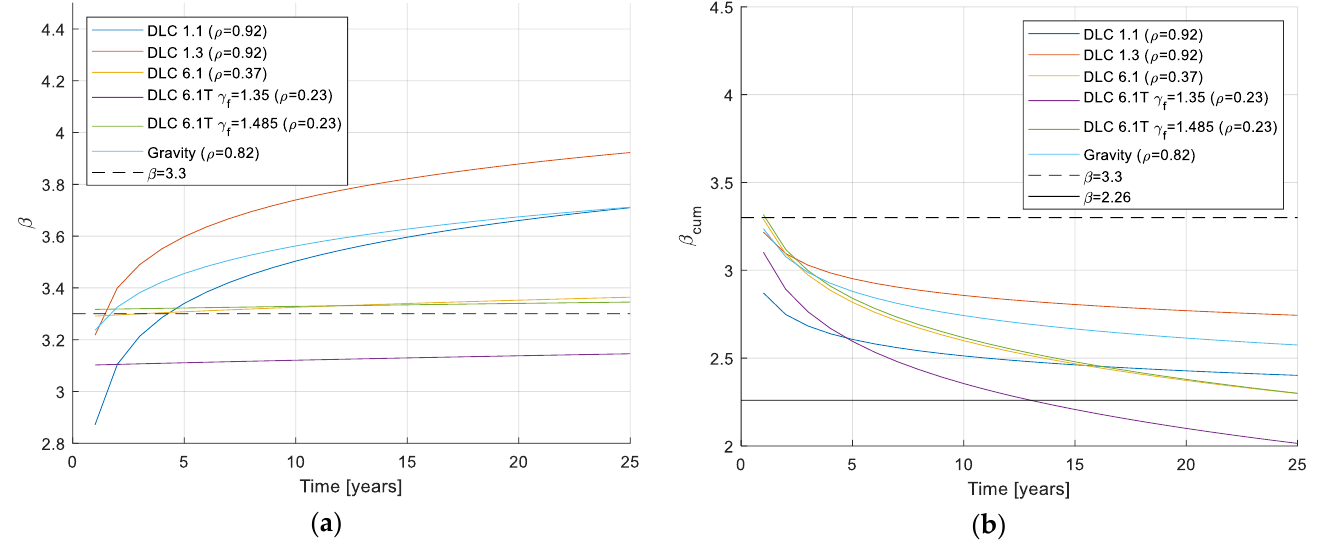
Figure 3. Reliability index as a function of time for steel, component class 2: ( a ) annual reliability index; ( b ) cumulative reliability index.